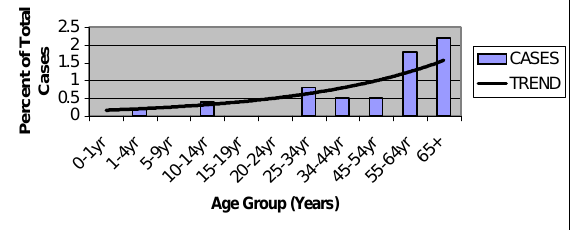
Figure 4: Annual percentages of total deaths by age caused by salmonella in Louisiana during the years of 1987-2001(LDHH 2001).